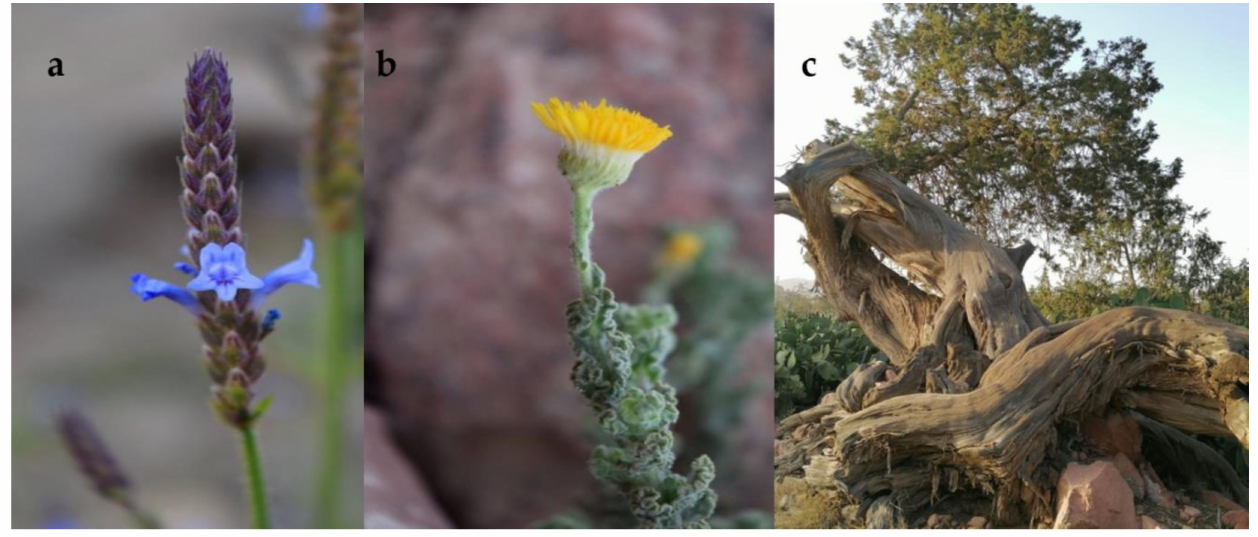
Figure 1. ( a ) Lavandula pubescens flowering aerial part; ( b ) Pulicaria incisa ssp. candolleana flowering aerial part; ( c ) Juniperus procera